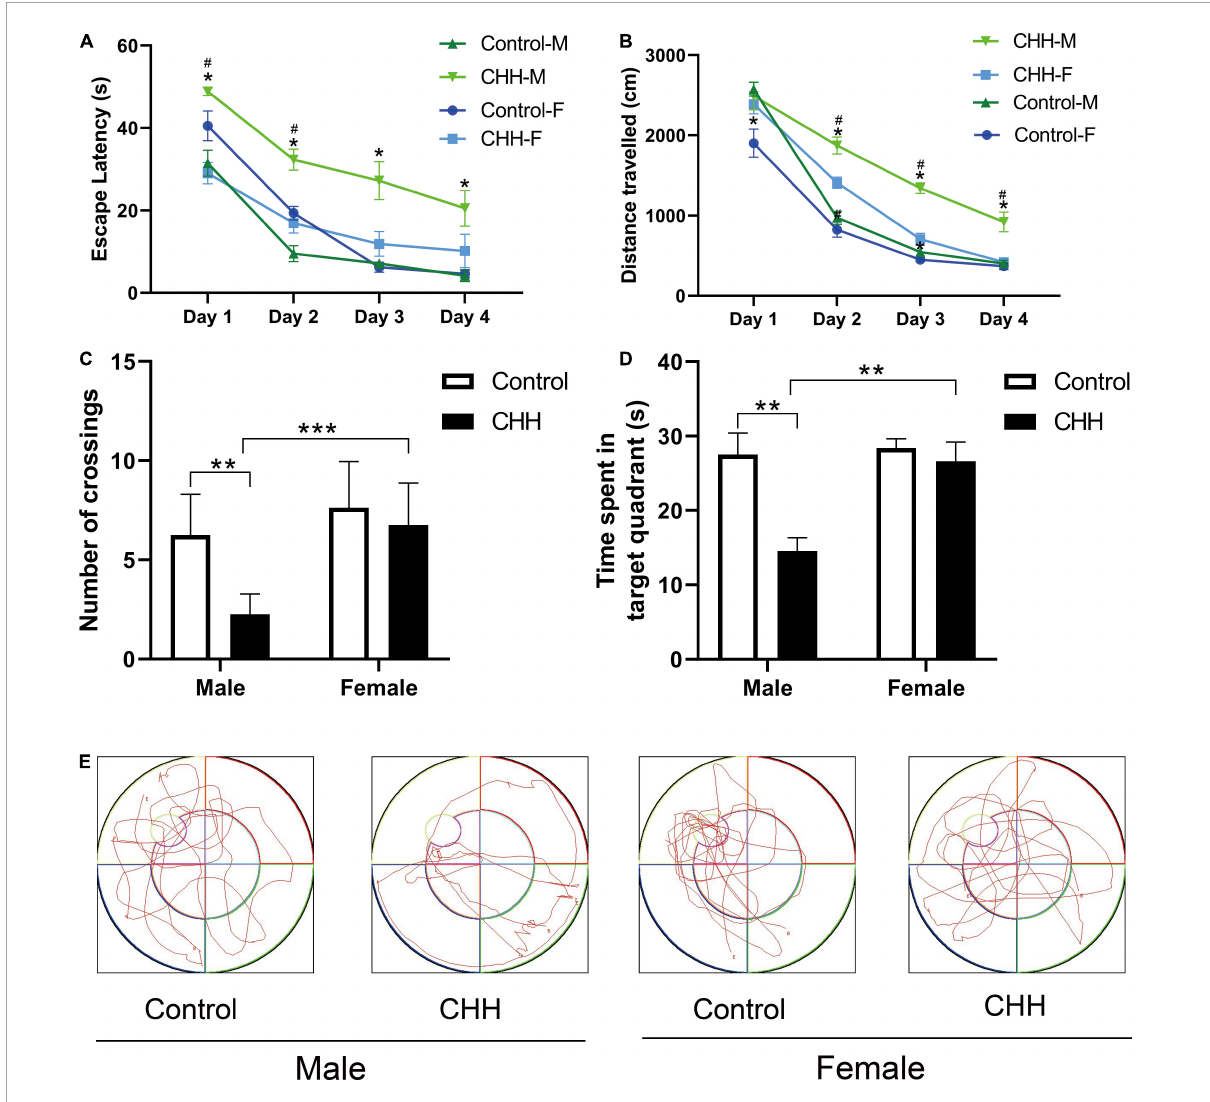
FIGURE3 Chronic hypobaric-hypoxia exposure impairs spatial learning and memory in rats. (A) Escape latency given in seconds; (B) path length given in centimeters; (C) the crossing times over the location of the platform; (D) time spent in target quadrant; (E) representation of the pattern in the probe trial. CHH: Chronic hypobaric hypoxia. Values are means ± SD for eight animals/group. Data for male and female rats, with or without CHH exposure, were analyzed using two-way ANOVA. Post hoc analysis indicated: * p < 0.05, ** p < 0.01, *** p < 0.001.